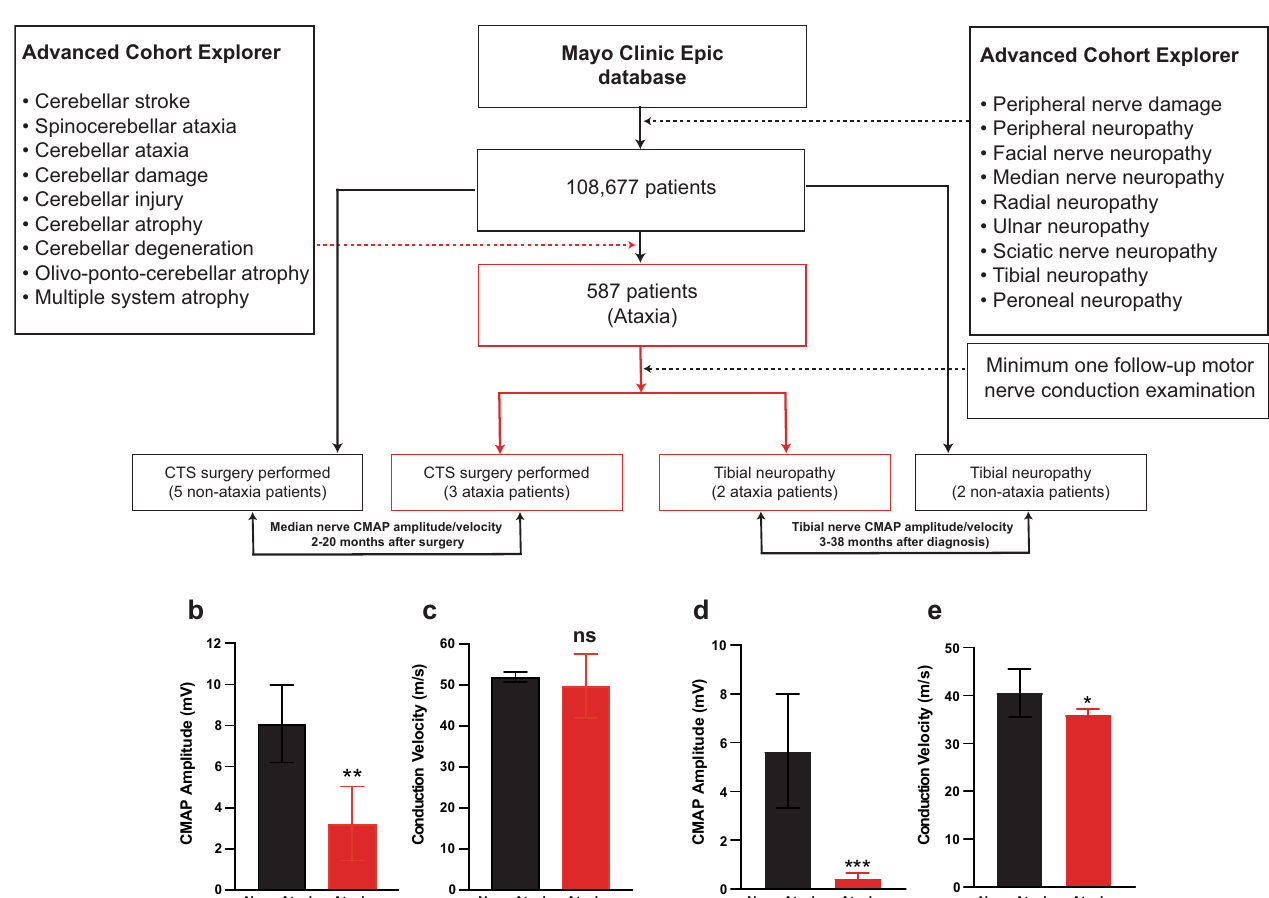
Fig. 8 Ataxia patients fail to recover motor nerve conduction after carpal tunnel decompression surgery or tibial neuropathy. a Flow diagram illustrating patient study population selection. Utilizing the Mayo Clinic Epic electronic database, 12 patients were identi fi ed for motor nerve conduction data analysis. b and c Median nerve compound muscle action potential (CMAP) motor amplitude and conduction velocity after 2 – 20 months of carpal tunnel syndrome (CTS) surgery in ataxia ( n = 3) and non-ataxia ( n = 5) patients. Ataxia patients recovered the median nerve conduction to a lesser extent even after carpal tunnel decompression surgery. d and e Tibial nerve CMAP motor amplitude and conduction velocity after 3 – 38 months of tibial neuropathy in ataxia ( n = 2) and non-ataxia ( n = 2) patients. Non-ataxia patients tend to spontaneously recover full motor function during a comparable period of time for both groups of patients. Values represent the mean ± SD (standard deviation); * P < 0.05; ** P < 0.01; *** P < 0.001, unpaired Student ’ s t